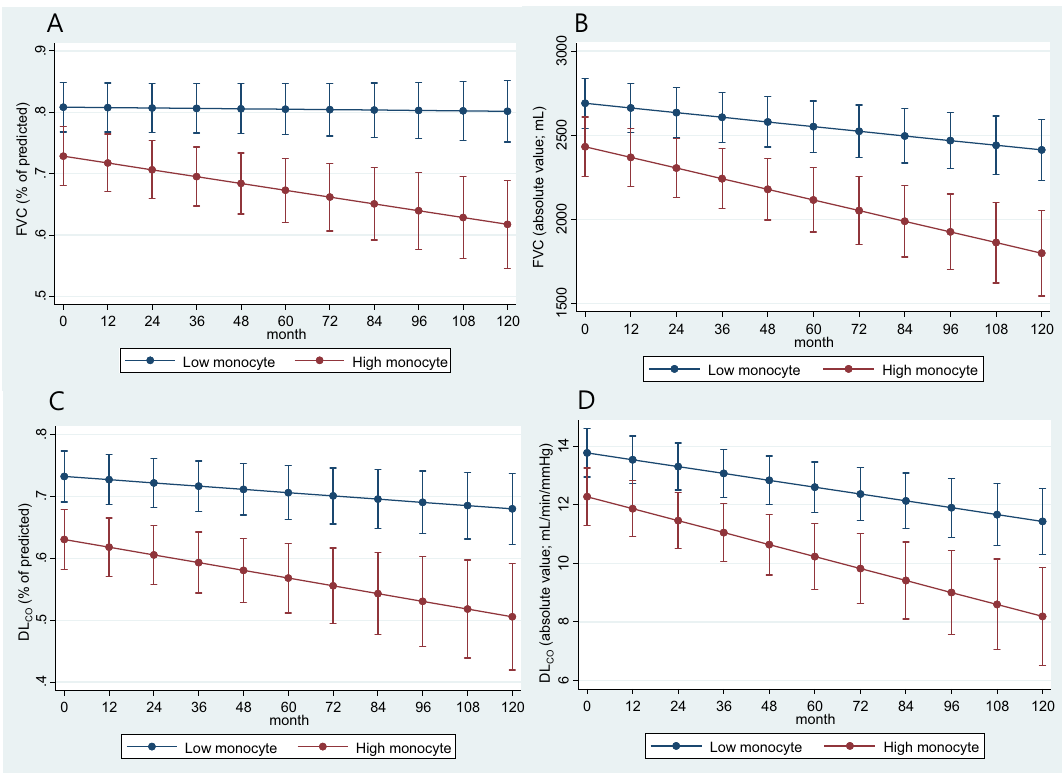
Figure 1. Changes in mean pulmonary function over time with a linear mixed-effects model in the study patients according to monocyte count group. ( A) Change of FVC (% of predicted). ( B) Change of FVC (mL). ( C) Change of DL CO (% of predicted). ( D) Change of DL CO (mL/min/mmHg). Each bar represents 95% confidence interval. Clinical course and survival according to monocyte count. The proportion of patients who experi- enced relapse tended to be high in the high-monocyte group, but there was no statistical difference between the two groups (low vs. high: 26.0% vs. 39.6%; P = 0.106). The proportion of patients with a history of acute exacer- bation was higher in the high-monocyte group than in the low-monocyte group (Table 1). Time to first event of acute exacerbation in the low- and high-monocyte groups is shown in Fig. 2A. The high-monocyte group had a shorter time to first event of acute exacerbation than the low-monocyte group ( P < 0.001).